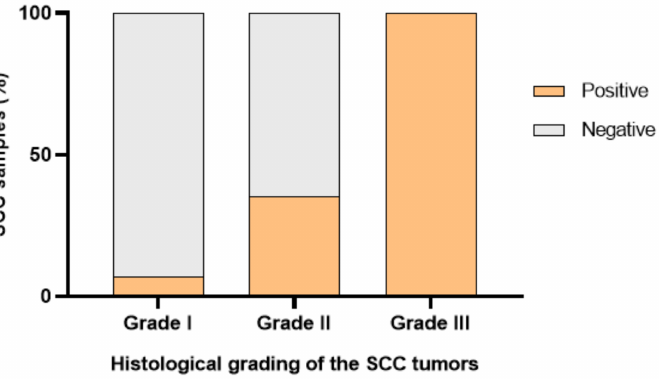
Figure 1. CTEN immunoreactivity (positive and negative) in grade I, grade II, and grade III